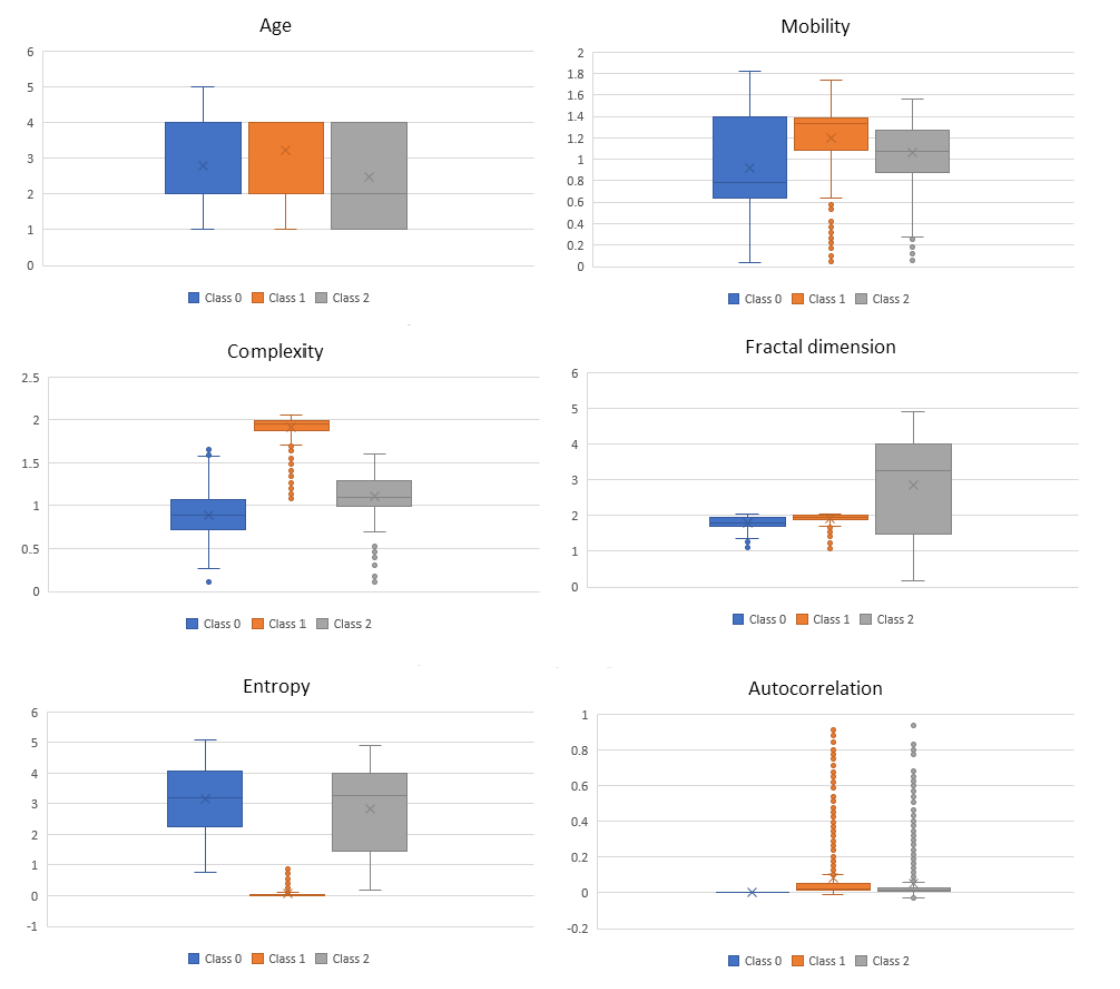
Figure 4. Box-and-whisker plots per class for the complexity